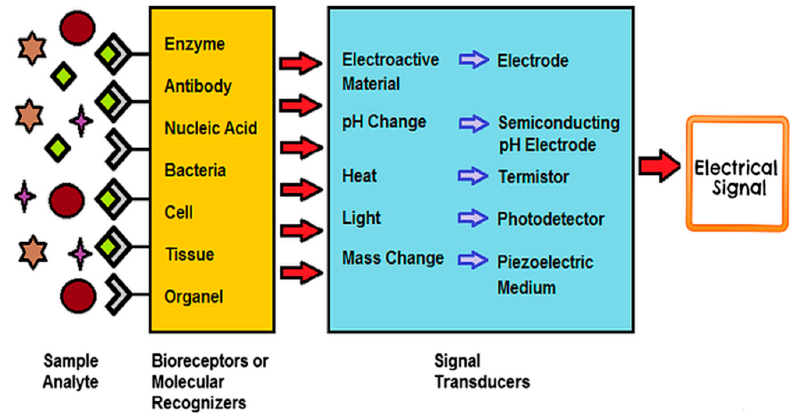
Figure 2. Different approaches to sensors [96]. Figure 2. Di ff erent approaches to sensors